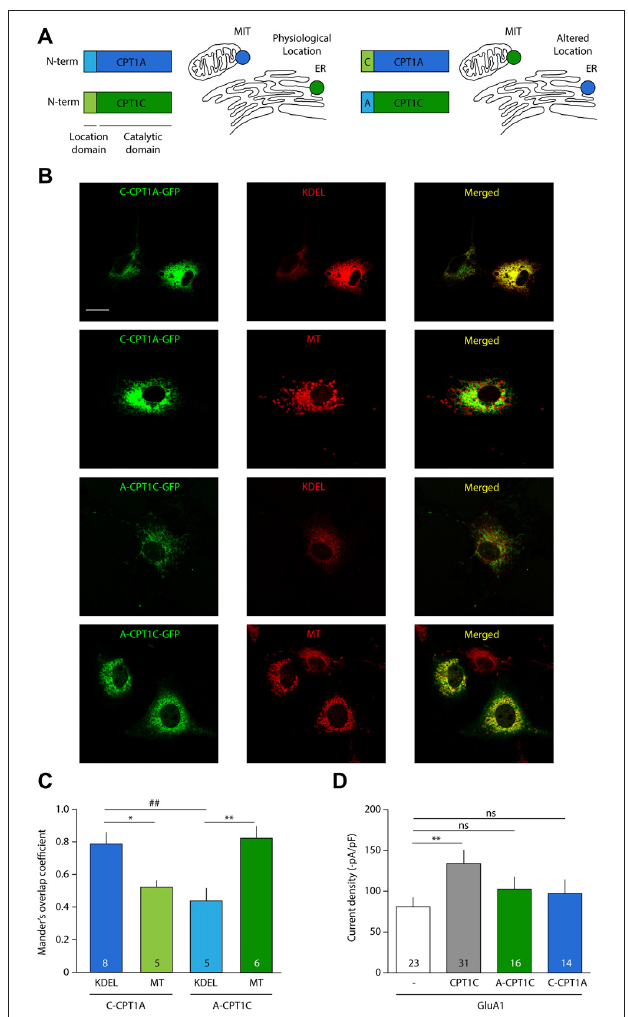
FIGURE 8 | CPT1C effect on AMPAR currents is isoform specific and depends on ER location. (A) N-terminal domain of CPT1s determines its intracellular location. Chimeric proteins C -CPT1A (CPT1A with the location domain of CPT1C) and A -CPT1C (CPT1C with the location domain of CPT1A) are miss-localized to endoplasmic reticulum (ER) and mitochondria (MIT/MT), respectively. (B) Confocal images showing CPT1s-GFP signal in green (left columns), KDEL or mitotracker signal in red (middle column) and merged images (right columns) for the two chimeric CPT1s proteins. C -CPT1A clearly co-localizes with ER while A -CPT1C is not co-localizing with KDEL ER marker. (C) Representation of co-localization values quantified by Manders’ overlap Coefficient (MOC) expressed as mean ± SEM. Numbers in bars denote number of analyzed cells ( ∗ p < 0.05; ∗∗ , ## p < 0.01; Mann-Whitney-U-test). (D) Average of normalized current density at –80 mV for GluA1 alone or together with CPT1C or chimeric proteins. No significant differences were found between GluA1 current density (–pA/pF) in cells co-expressing A -CPT1C or C -CPT1A ( ns p > 0.05; Mann-Whitney-U-test).